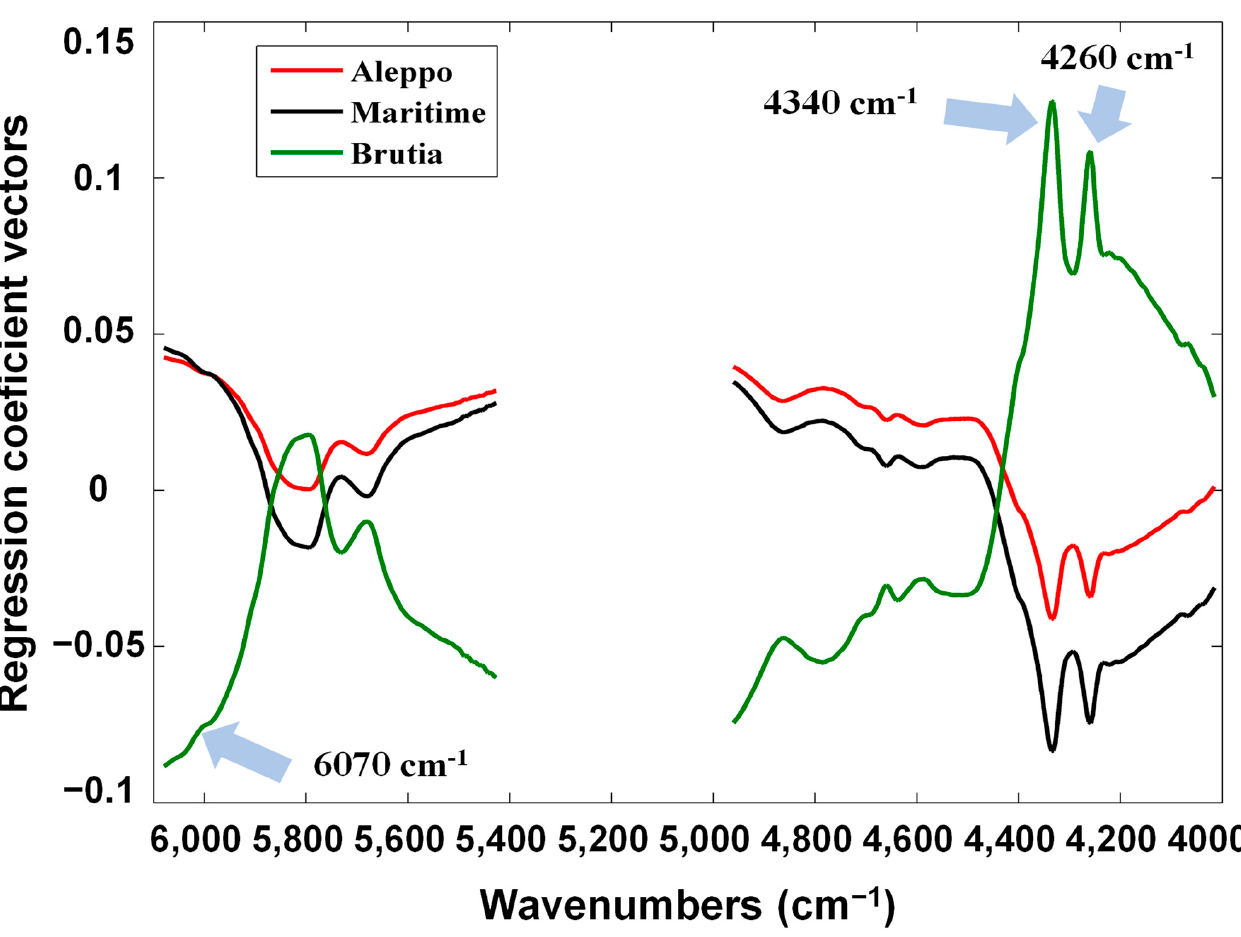
Figure 3. Regression coefficient vectors for the best PLS-DA model regarding pine seeds species discrimination using the spectral regions R1 and R3 and 2 LV for the validation set.